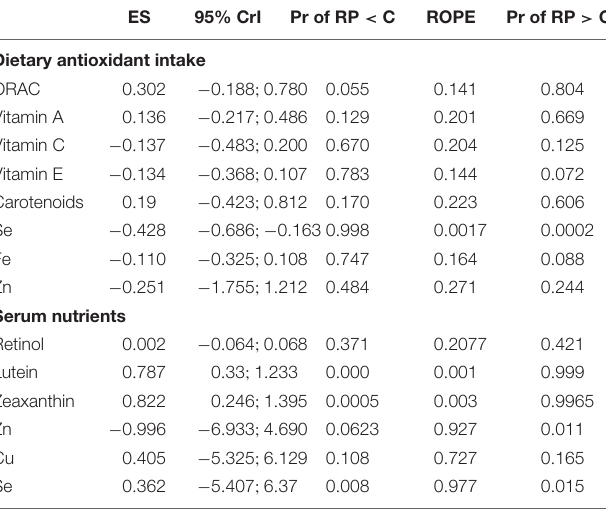
TABLE 2 | Bayesian analysis of estimated dietary intakes and blood nutrients in controls and RP